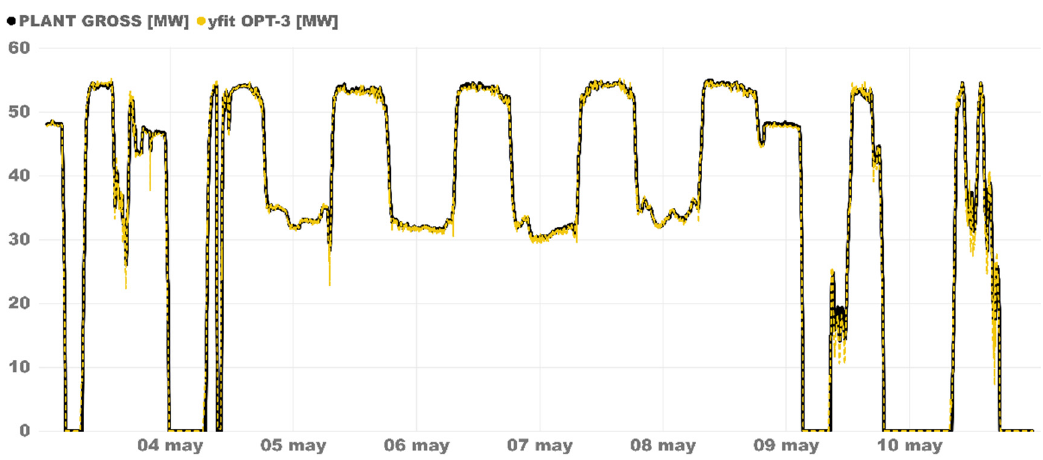
Figure 4. OPT-3 model validation in a continuous operation week.